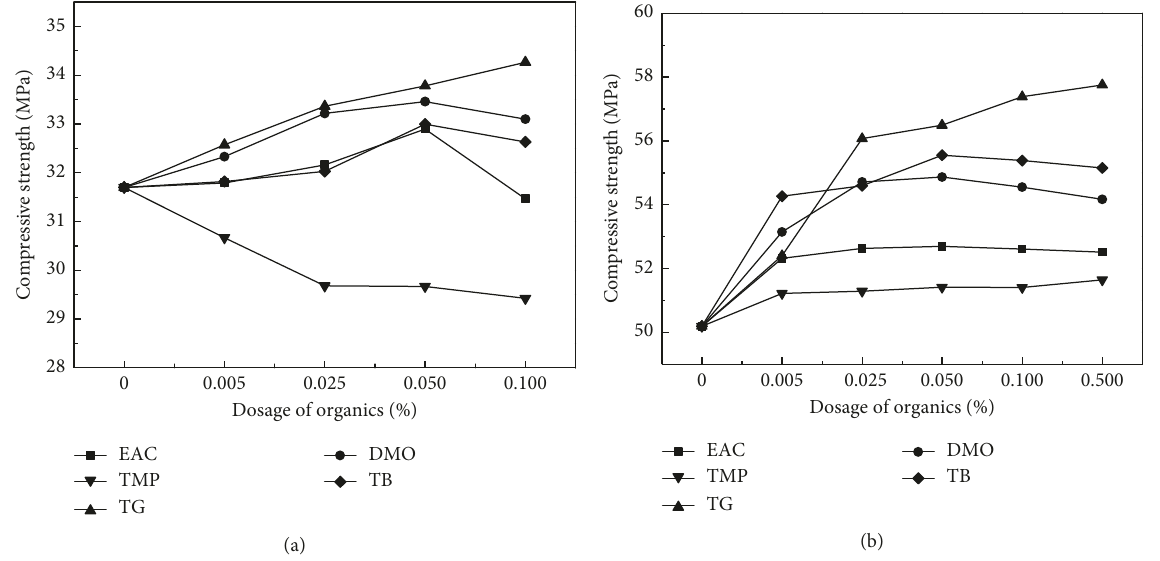
Figure 8: Effect of esters on the compressive strength of cement mortar. (a) 3d. (b)